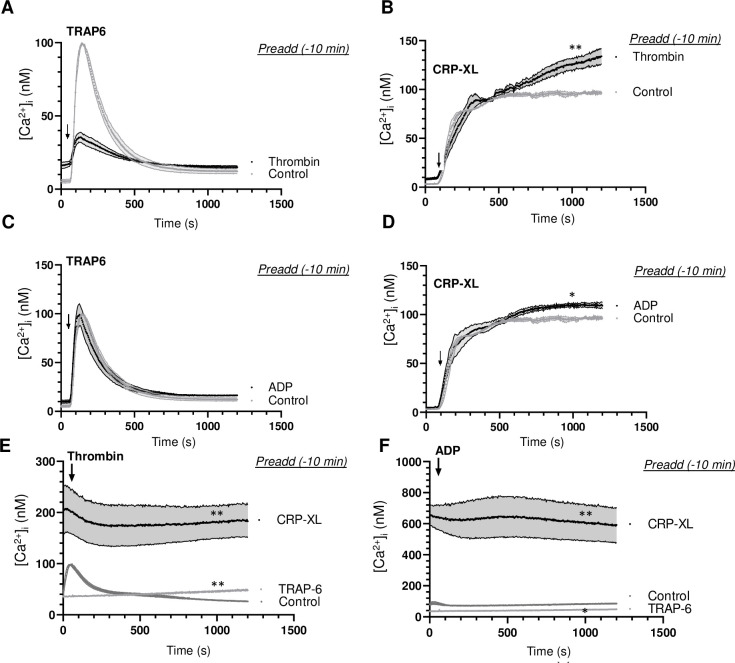
Effect of agonist stimulation on Ca2+ signalling induced by a second agonist.Calibrated [Ca2+]i rises were recorded during 25 min of Fura-2-loaded platelets in 96-wells plates. Platelets were stimulated at indicated time point (arrow) as second agonist with 10 μM TRAP6 (A, C), 5 μg/mL CRP-XL (B, D), 1 nM thrombin (E) or 1 μM Me-S-ADP (F). (A, B) Preaddition of vehicle (control) or thrombin (1 nM) at 10 min before second agonist. (C, D) Preaddition of vehicle (control) or Me-S-ADP (1 μM) at 10 min before second agonist. (E, F) Preaddition of vehicle (control), TRAP6 (10 μM) or CRP-XL (5 μg/mL) at 10 min before second agonist. Means ± SEM (n = 3 experiments). *P<0.05, **P<0.001 vs. controls at t = 1000 s, paired Student t-test.